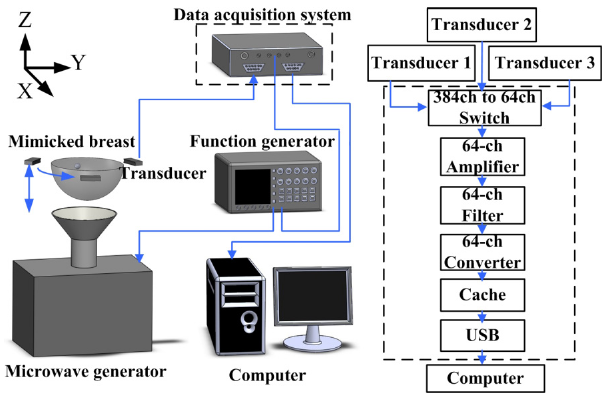
Fig. 3. Schematic of the experimental setup for microwave- induced thermoacoustic data acquisition system.